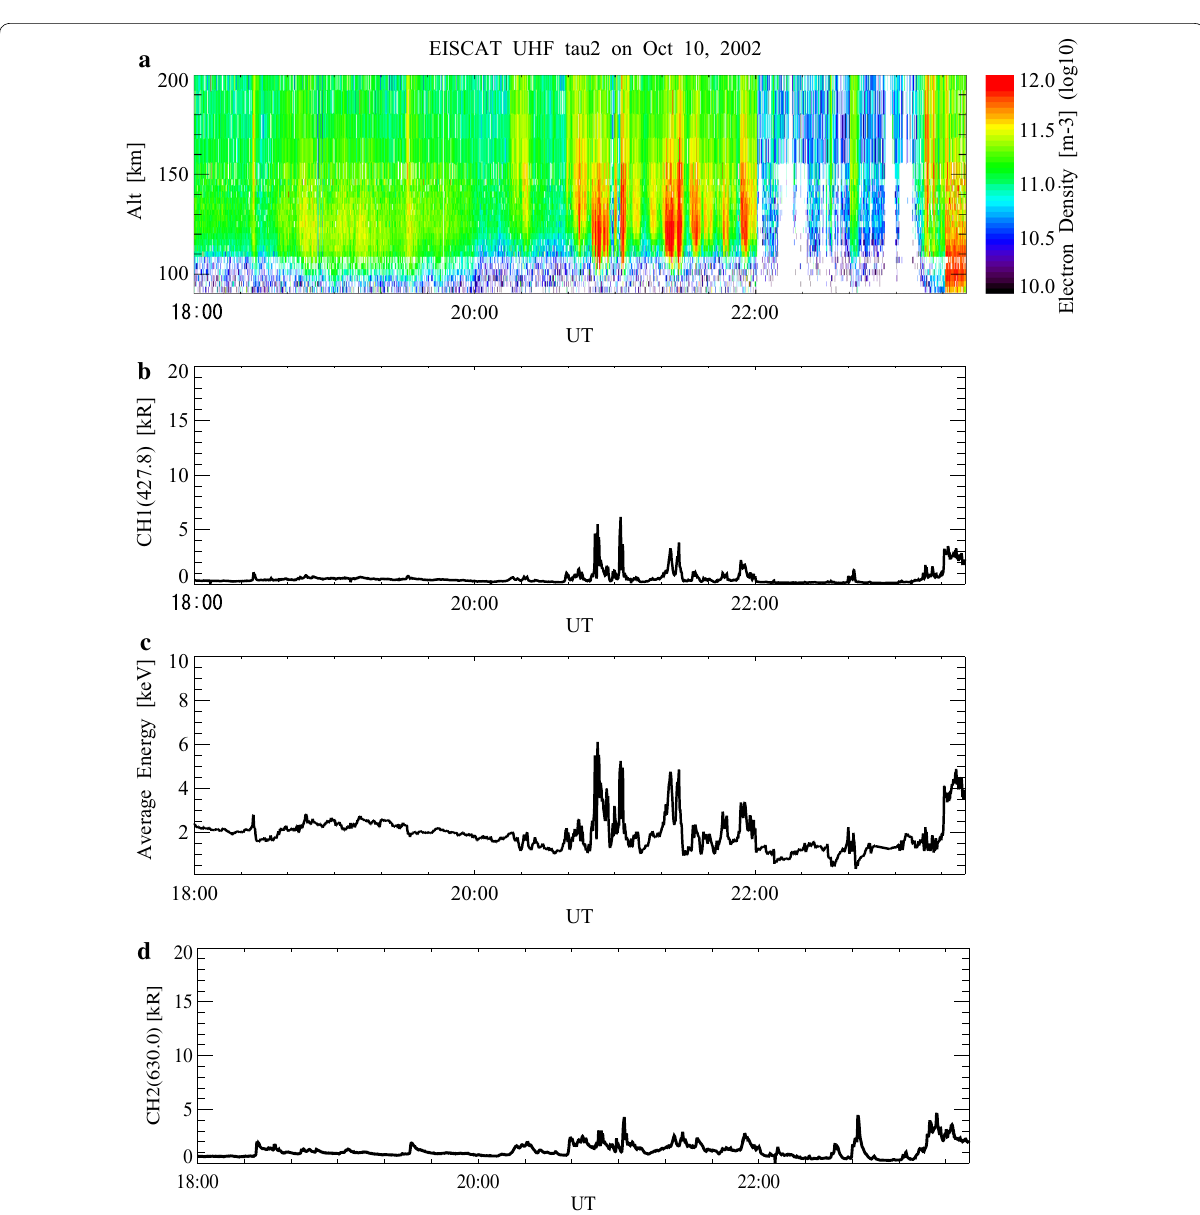
Fig. 2 EISCAT and photometer results for October 10, 2002; a time–altitude profiles of electron density obtained with the EISCAT UHF radar from 18:00 UT to 23:30 UT on October 10, 2002. b Temporal variation of the emission intensity at 427.8 nm observed by the photometer. c Temporal variation of the average energy of the precipitating electrons derived from the emission intensity ratio of 427.8 to 630.0 nm from the photometer observations. d Temporal variation of the emission intensity at 630.0 nm observed by the